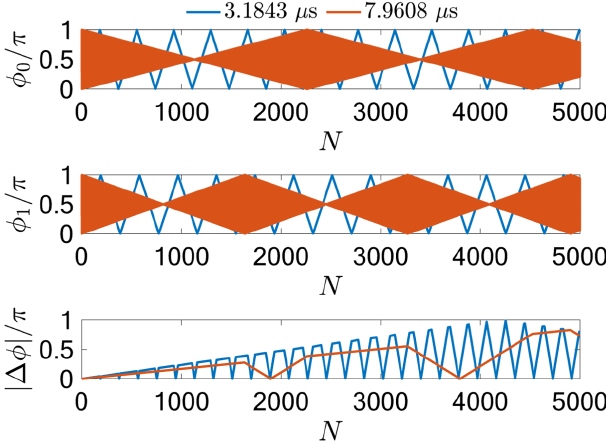
FIG. 16. Nuclear rotation angles ϕ 0 (top) and ϕ 1 (middle) as a function of iterations of a UDD 4 unit at the resonance time 3 . 1843 μ s or at 7 . 9608 μ s. The red lines show the fast oscillation of the rotation angles. The bottom plot shows the difference of the rotation angles as a function of N